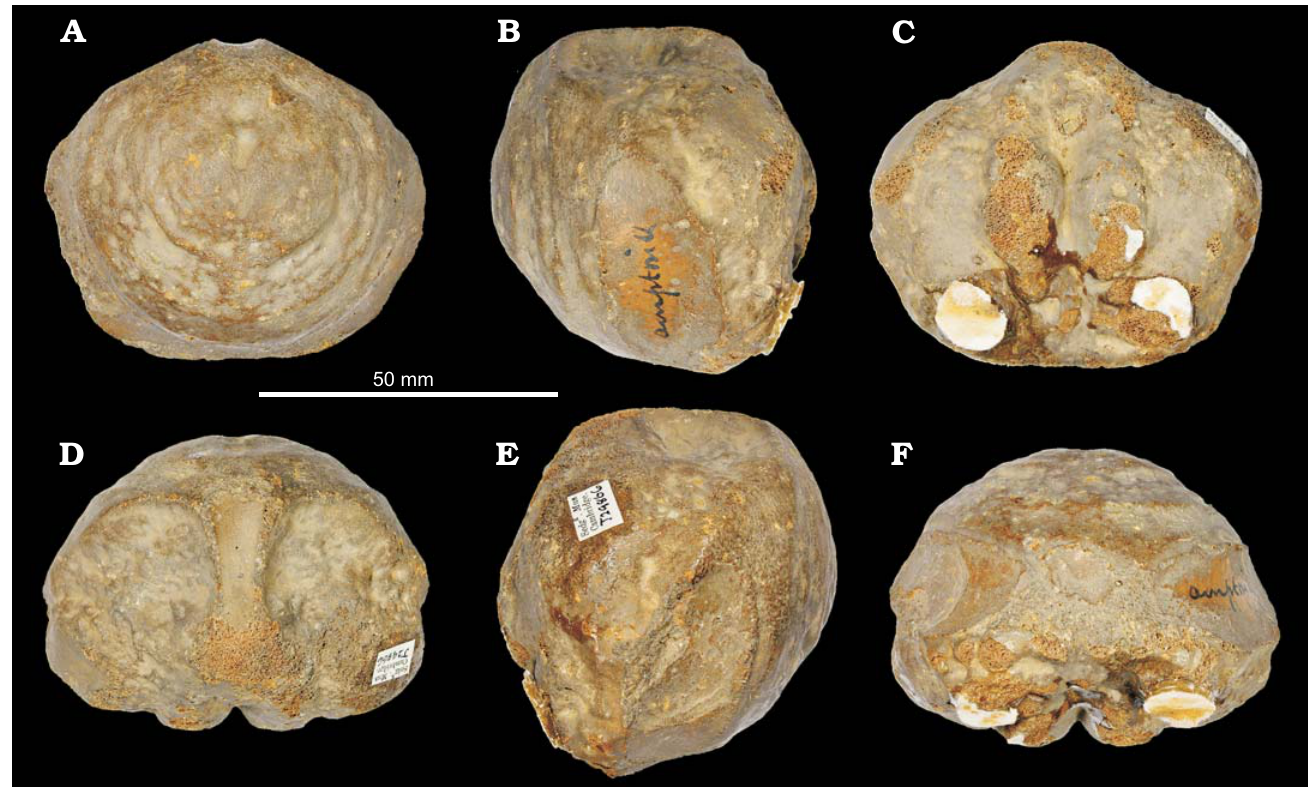
Fig. 8. Ichthyosaurid reptile Ophthalmosaurinae indet. (CAMSM J.29866), basioccipital from Ampthill (Bedfordshire), Oxfordian, in posterior ( A ), lat- eral ( B , E ), anterior ( C ), dorsal ( D ), and ventral ( F )